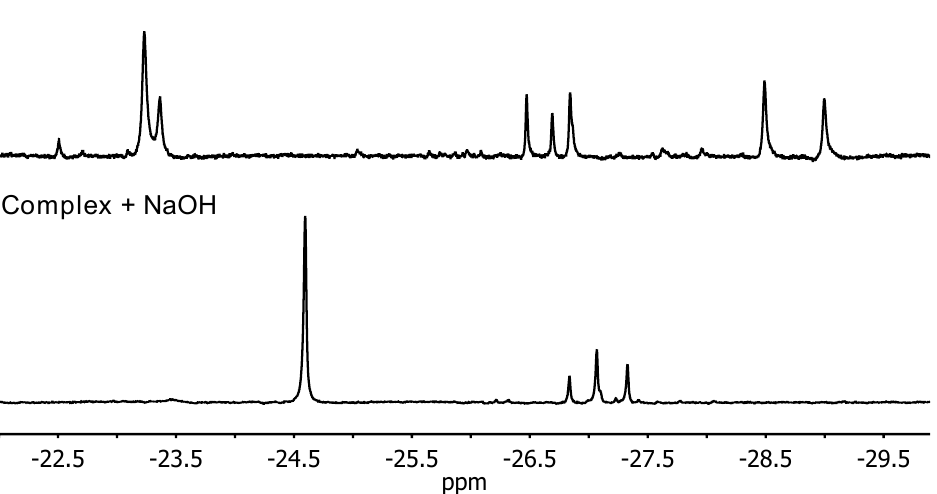
Figure 8. 1 H NMR spectra (400 MHz, IPA, DMSO- d 6 insert) showing the hydride resonances of Ir(IMe) 2 ( L -Pro)(H)(I) before ( top ) and after ( bottom ) the addition of